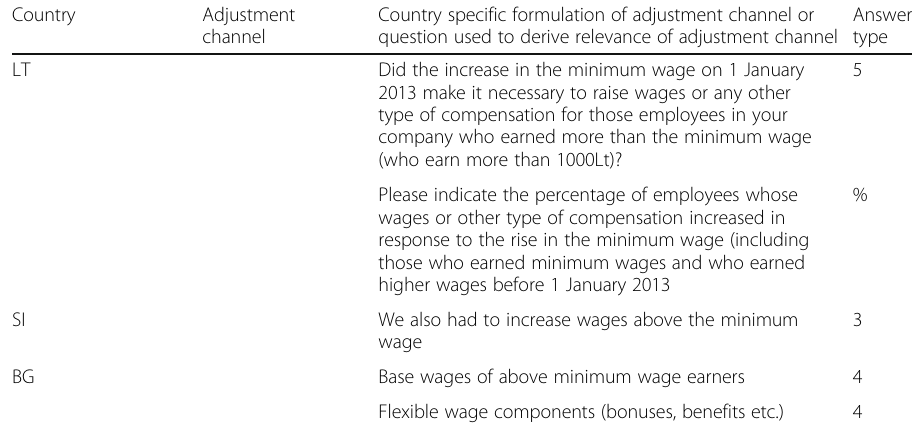
Table 8 Country-specific questionnaires: adjustment channels and answer options (Continued) Country